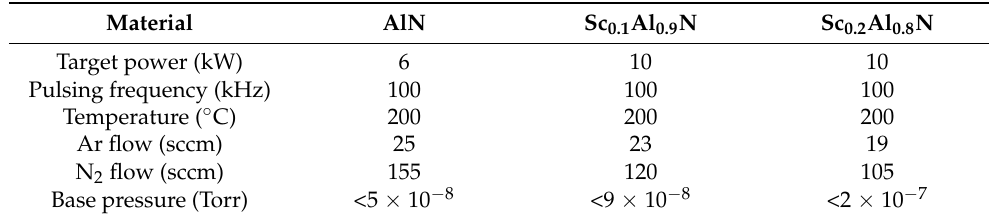
Table 1. The main preparation parameter of AlN, Sc 0.1 Al 0.9 N, and Sc 0.2 Al 0.8 N thin film. Material AlN